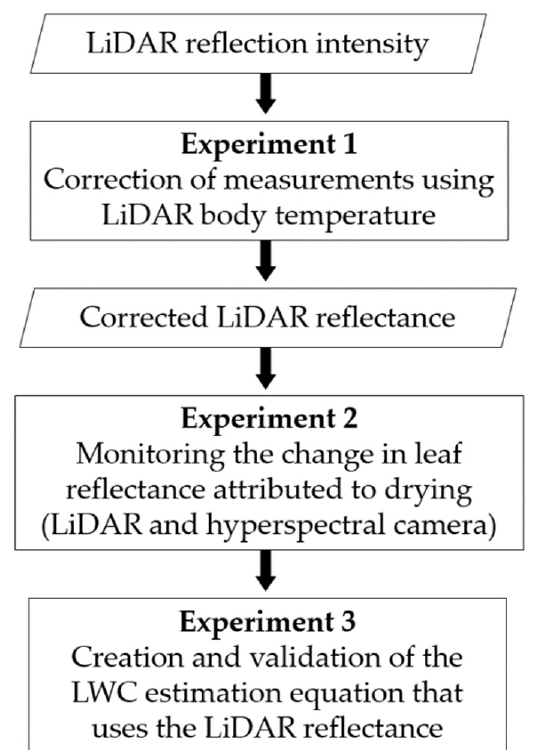
Figure 1. Flowchart of the experiment for LWC estimation.